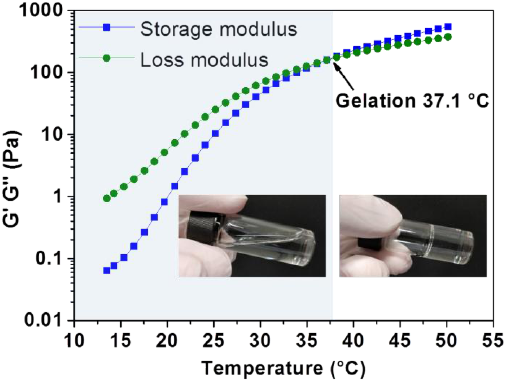
Figure 4. Dynamic rheology analysis of aqueous solution of poly(PEG/PPG/PTHF carbonate urethane) copolymer P2 (20 wt % concentration) as a function of temperature.